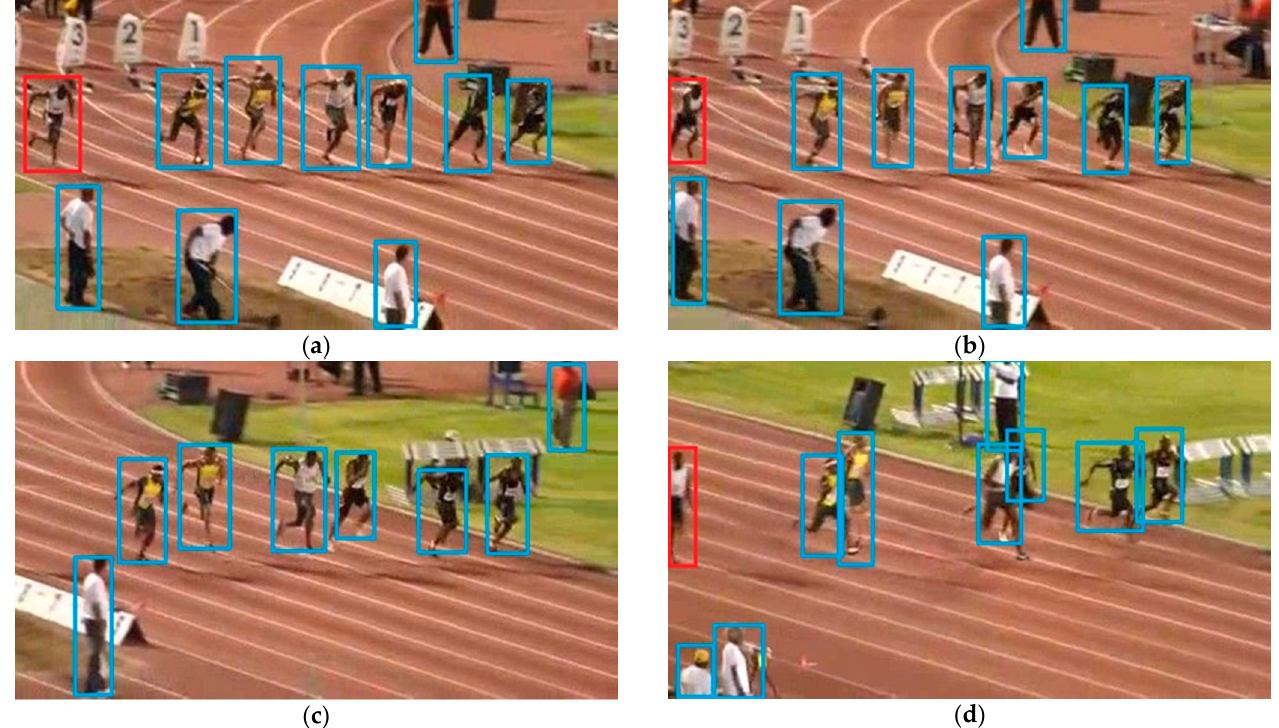
Figure 4. SCKFMDF solves the occlusion problem by comparing the deep features of 128-dimensional vectors of different people. ( a ) Tracking target is labelled with red bounding box; ( b ) tracking target is gradually left by the camera view for his slow running; ( c ) tracking target is completely lost in the camera view; ( d ) tracking target reappears and is found by SCKFMDF and labelled with red bounding box.